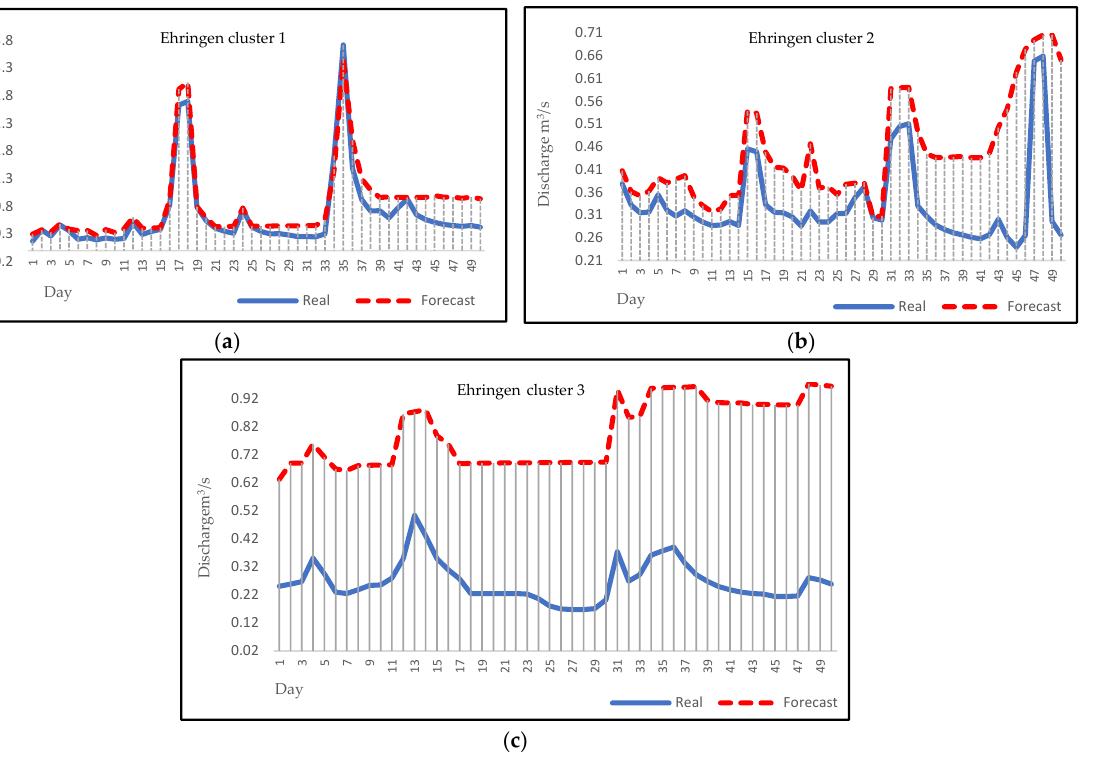
Figure 6. ( a ) Forecasting plot for Ehringen cluster 1; ( b ) forecasting plot for Ehringen cluster 2; ( c ) forecasting plot for Ehringen cluster 3.